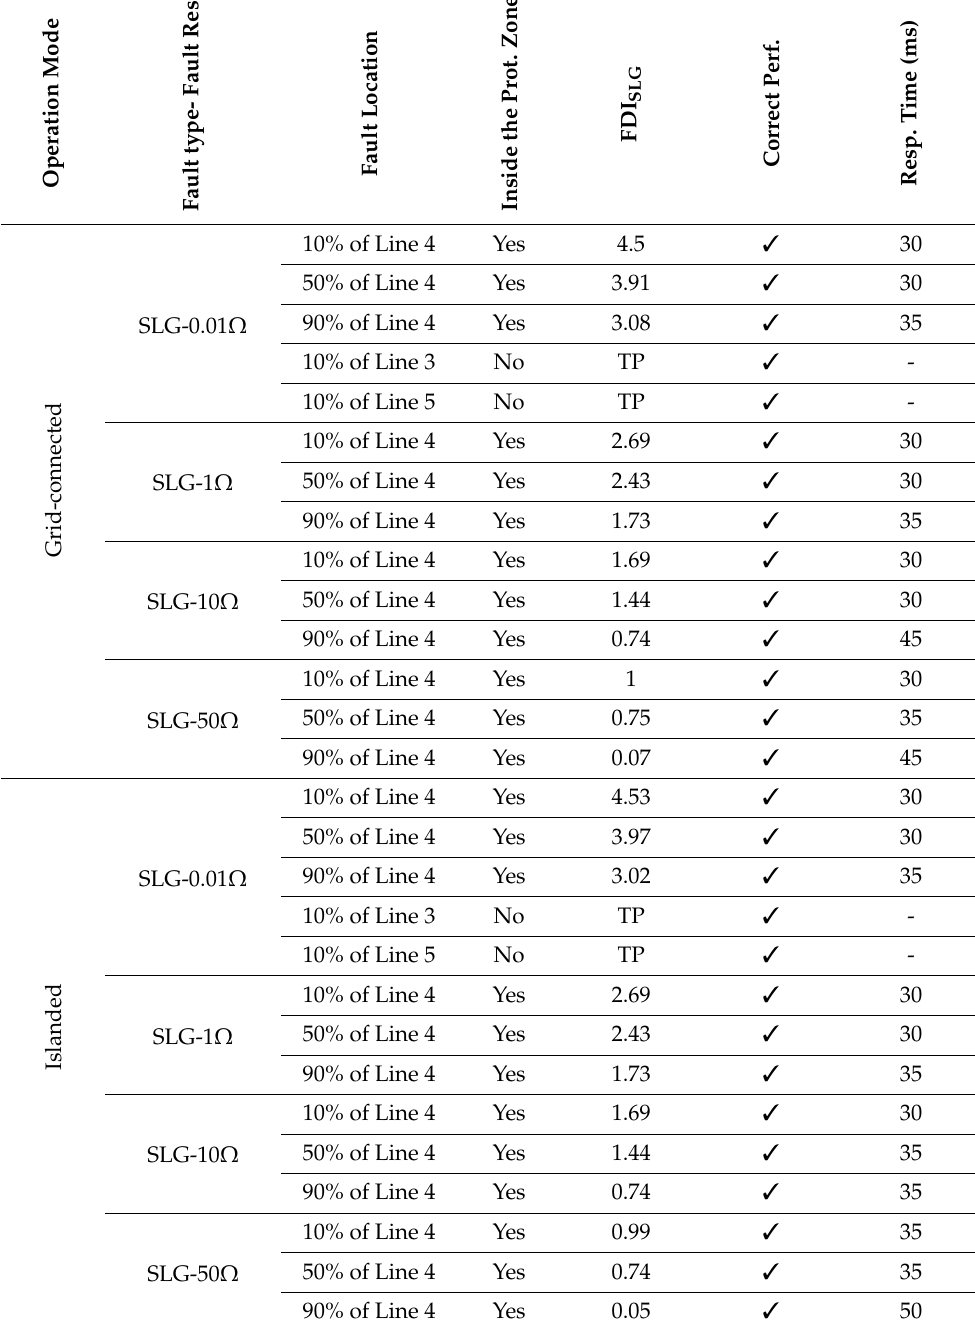
Table 4. Performance of the proposed main scheme in SLG